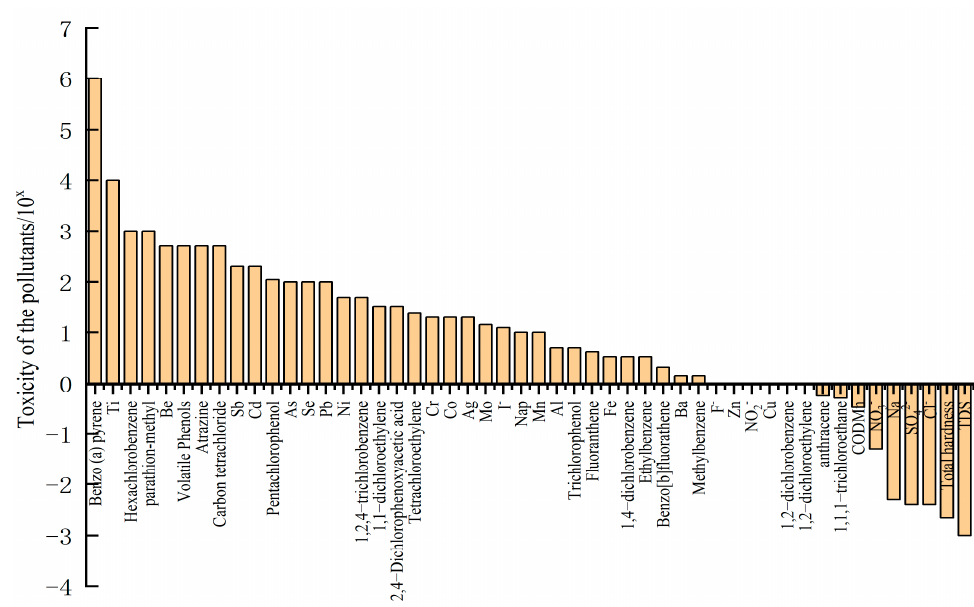
Figure 7. The toxicity scale of the